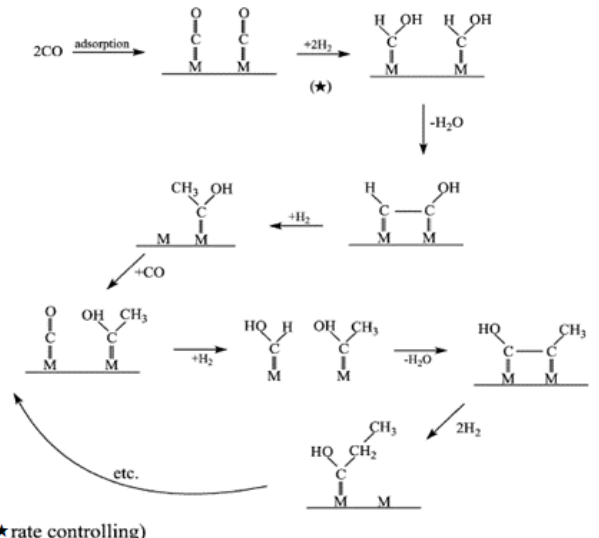
Figure 2. Schematic of enol mechanism. Reproduced with permission [13]. ★ : rate controlling step.